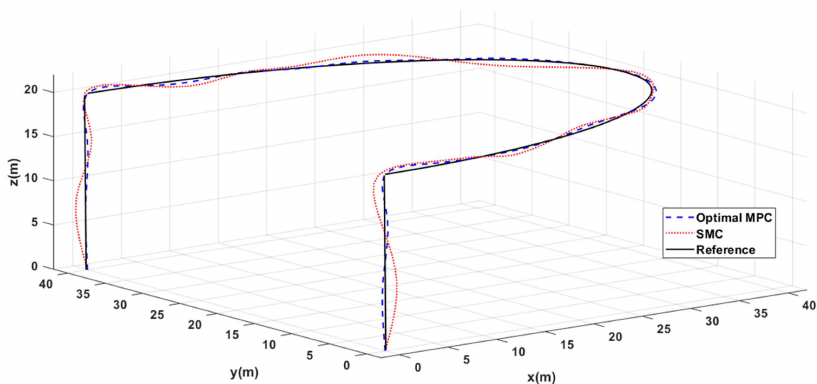
Figure 5. The result of applying the proposed control method and SMC method [50] to the helicopter in the fourth scenario.